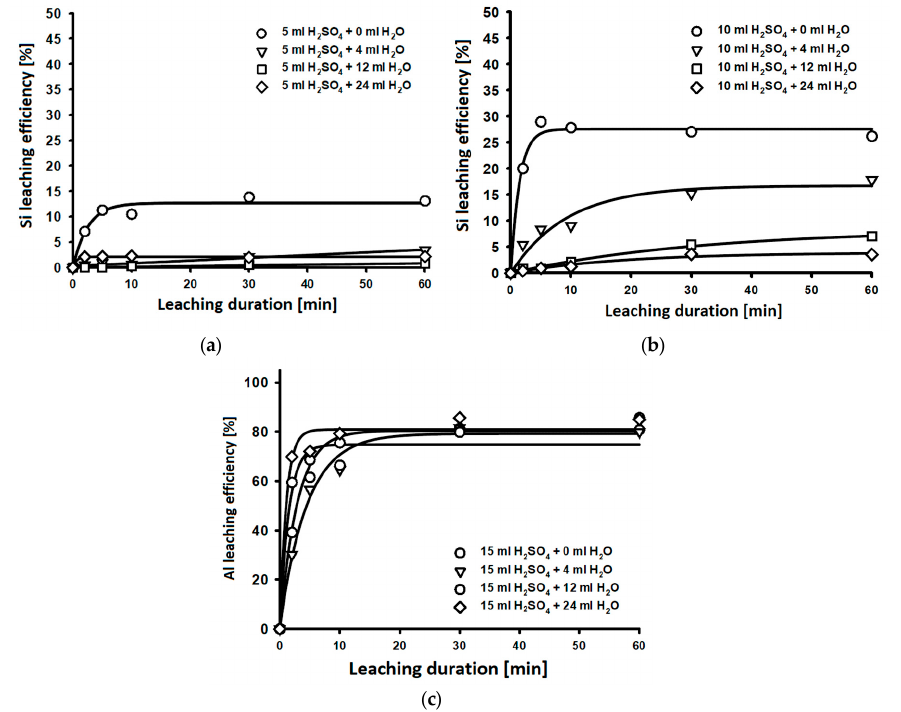
Figure 17. Aluminum leaching efficiency in H 2 O using ( a ) 5 mL of H 2 SO 4 , ( b ) 10 mL of H 2 SO 4 , ( c ) 15 mL of H 2 SO 4 .